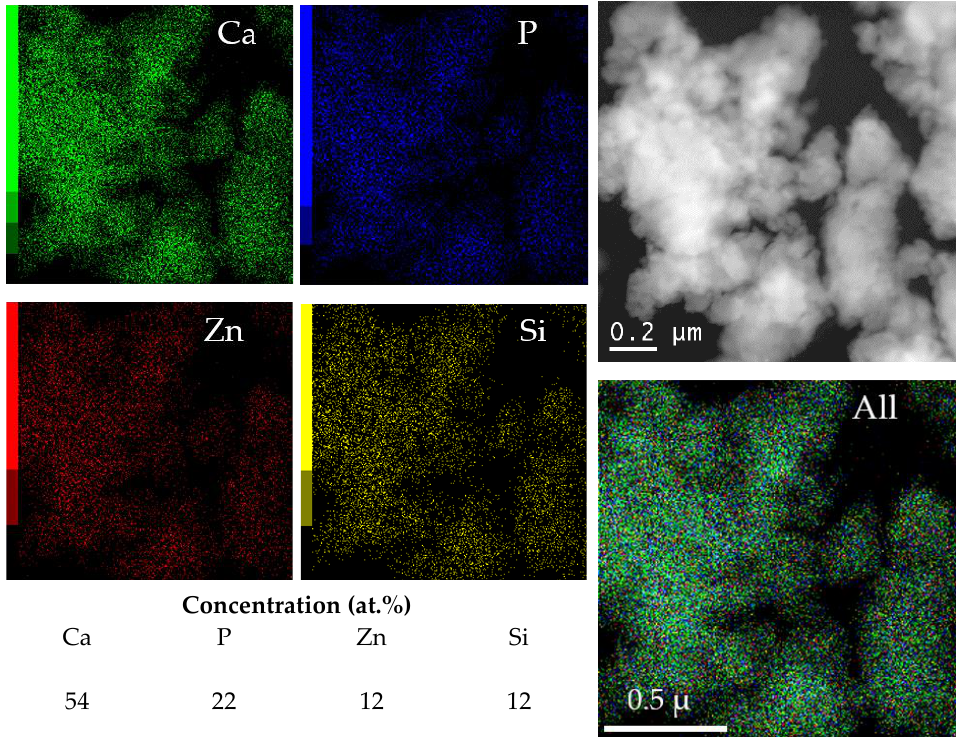
Figure 5. TEM ( a , b ) and HRTEM ( c , d ) images for HA ( a , c ) and 2.0-ZnSi-HA ( b , d ) samples.